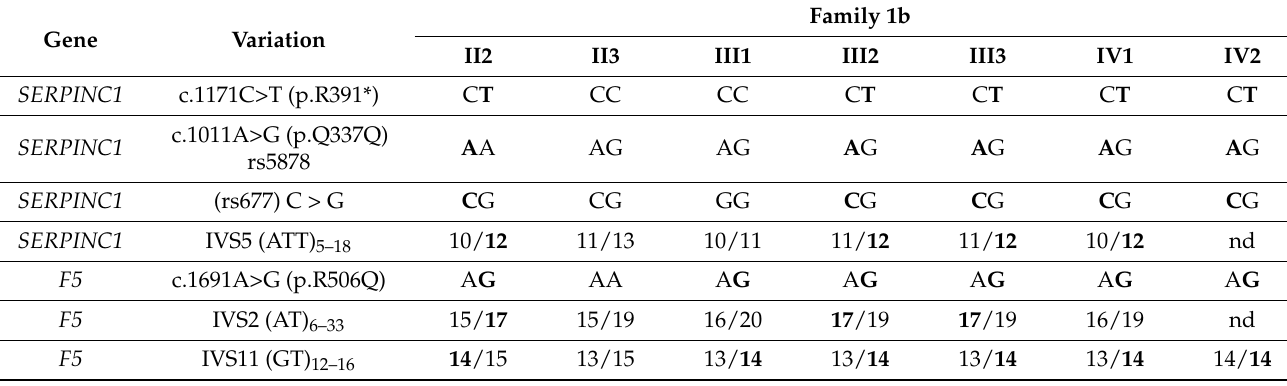
Table 2. Haplotyping in the members of Family